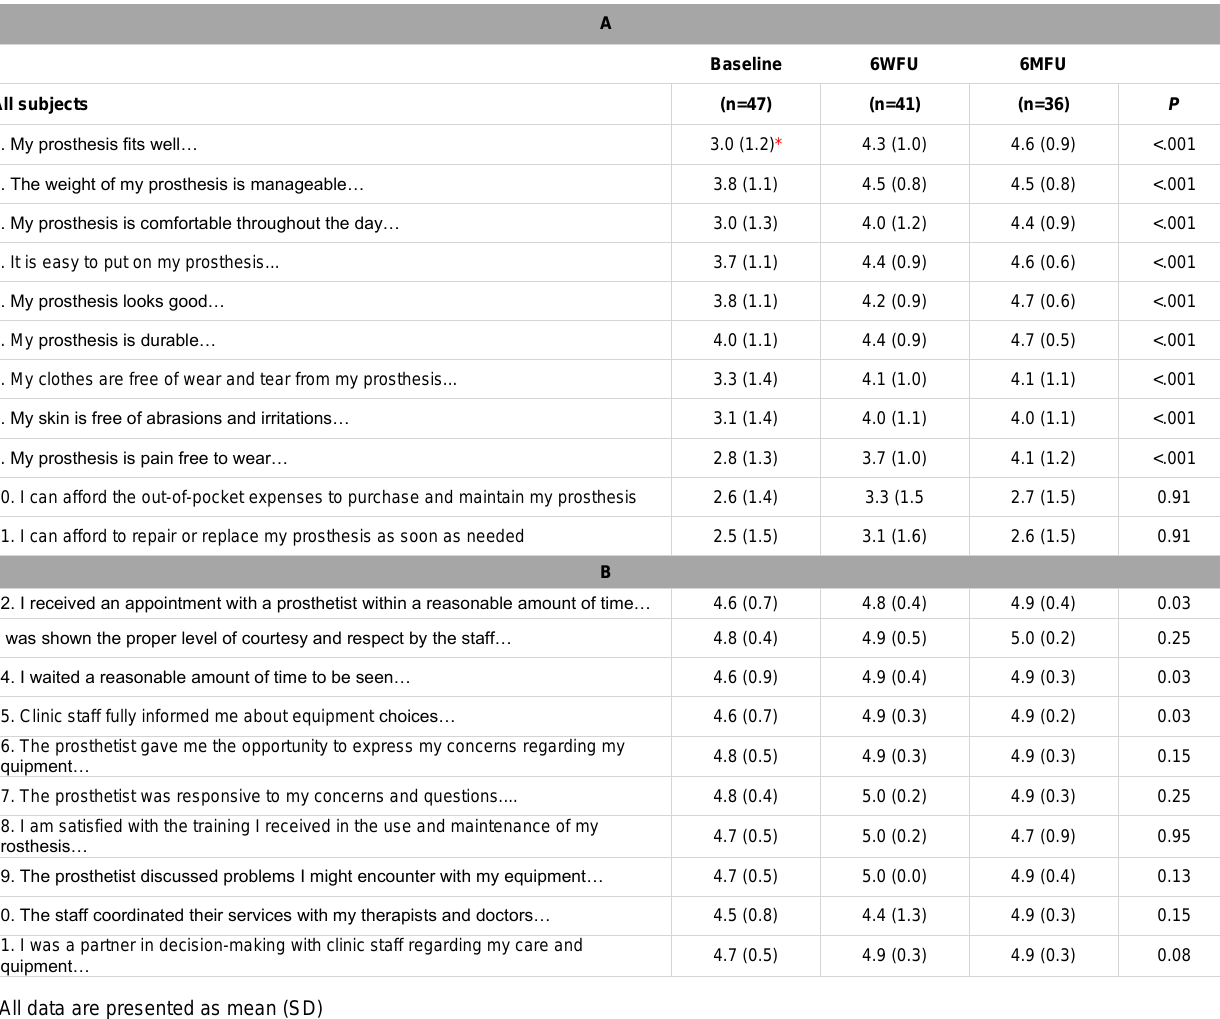
Table 3: A: OPUS Client Satisfaction Device (CSD) (questions 1-11). B: OPUS Client Satisfaction with Services (CSS) (questions 12-21)